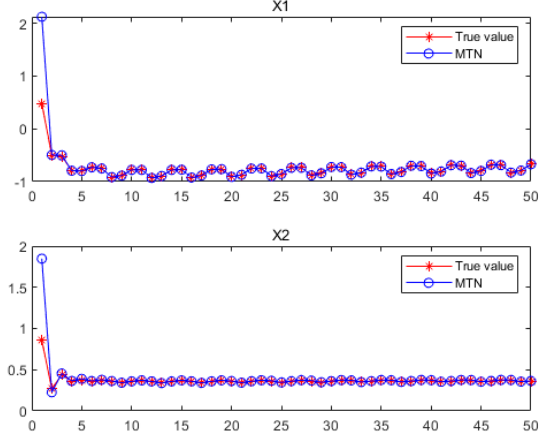
Figure 2. Graph of the MTN identification system in case 1.